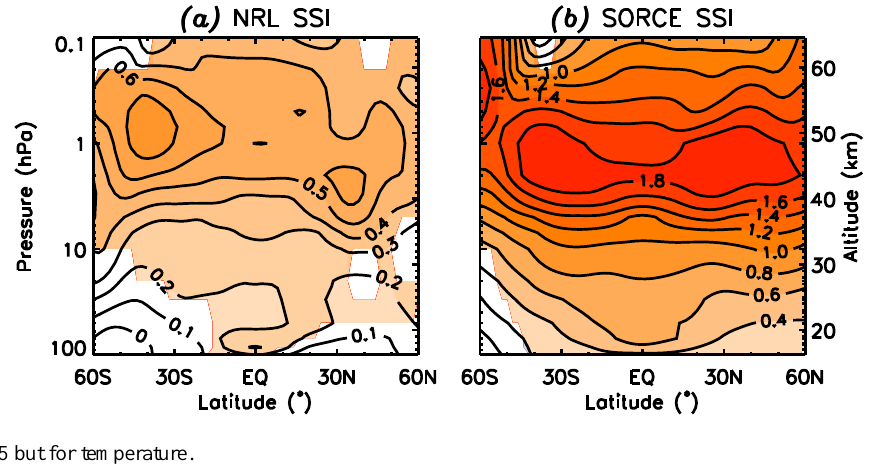
Fig. 8. Same as Fig. 5 but for temperature.